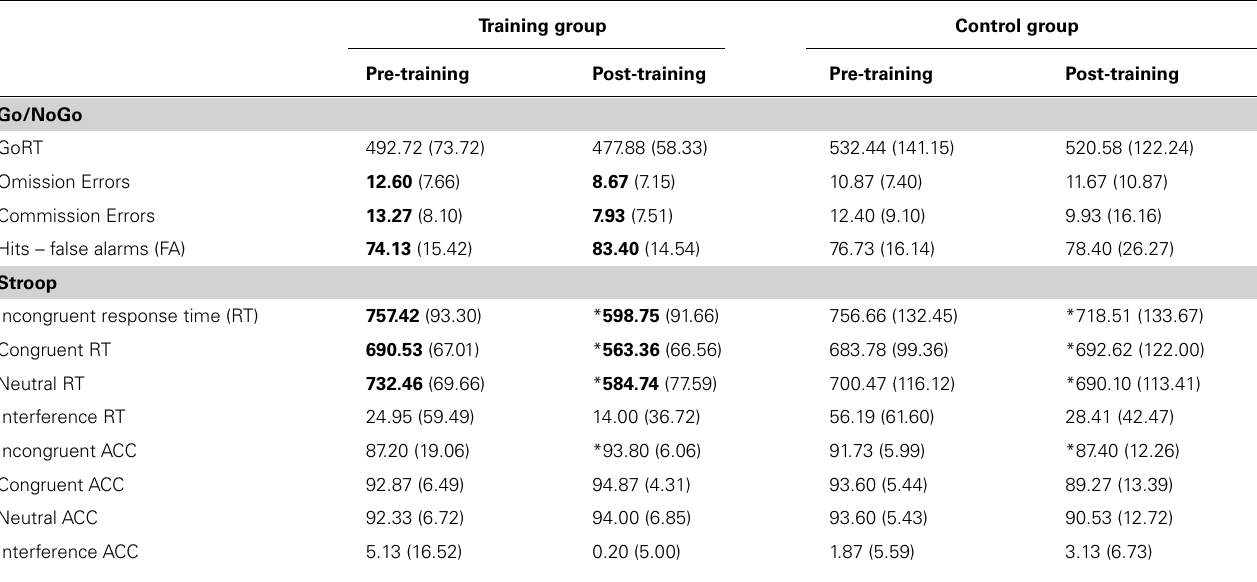
Table 1 | Groups’ mean (+SD) pre- and post training scores on the dependent measures of the go/no-go and Stroop